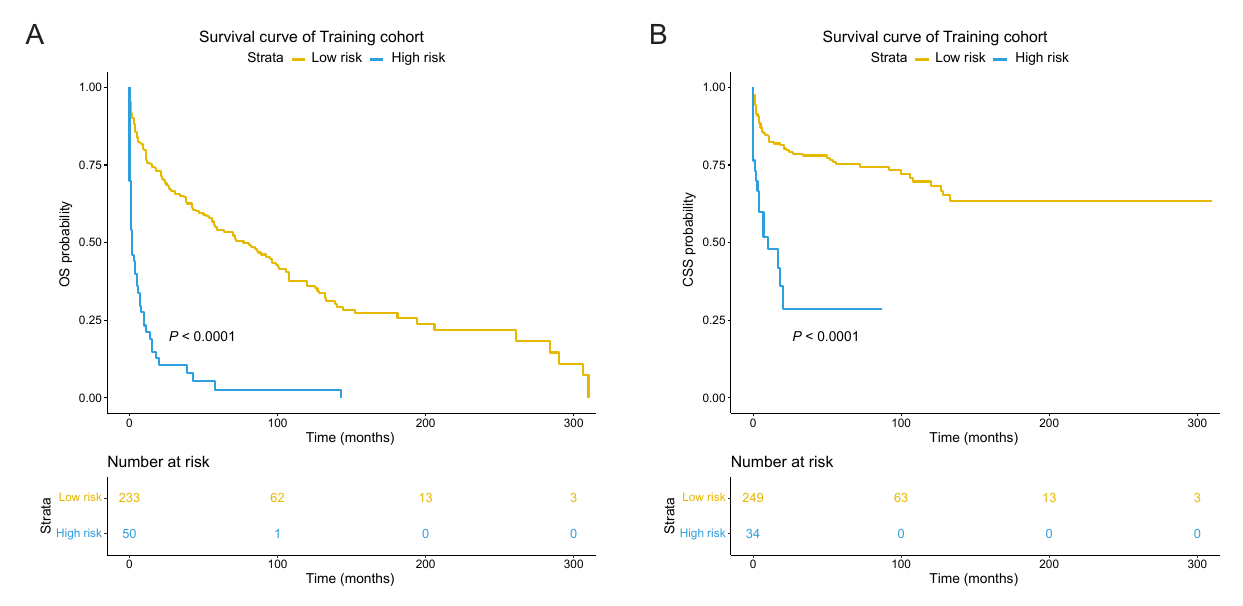
Figure 4. The OS ( A ) and CSS ( B ) Kaplan-Meier curves between high- and low-risk group of patients with primary bladder lymphoma in the training cohort. High-risk of OS: nomogram score ≥ 11.14; Low-risk of OS: nomogram score < 11.14; High-risk of OS: nomogram score ≥ 11.62; Low-risk of CSS: nomogram score < 11.62; OS, overall survival; CSS, cancer-specific